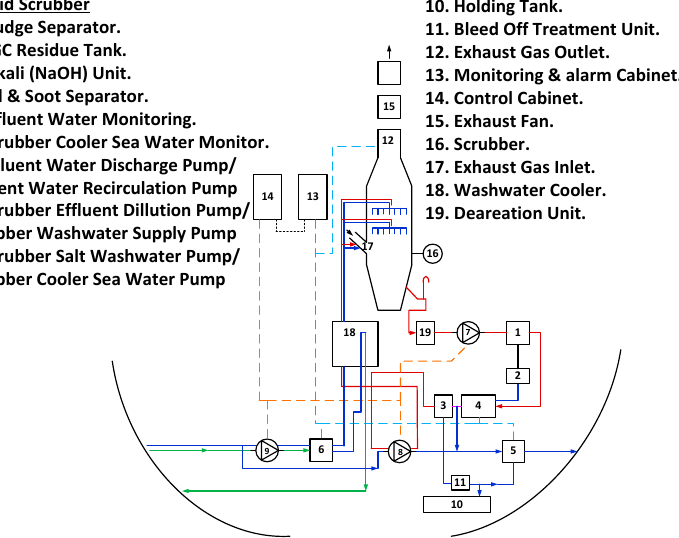
Figure 3. Schematic view of the on-board installation of a hybrid wet SO x scrubbing system operating with seawater (open-loop operation) or with an aqueous solution of NaOH (closed-loop operation). (Figure was genuinely generated using data from ref. [29]).